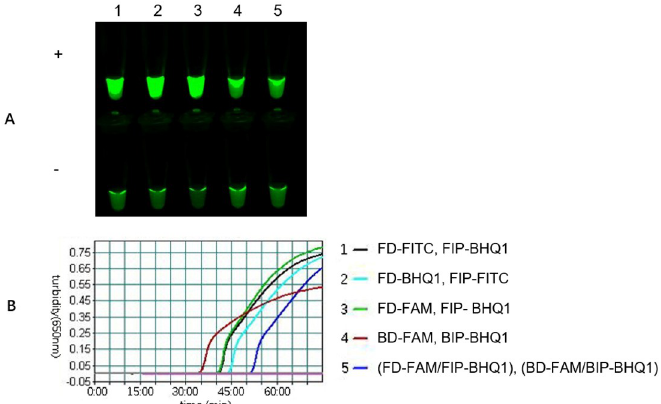
Fig 3. The effect of the labeling position of the fluorophore on the mLAMP reaction. The mLAMP products amplified by using FMDV-specific composite probes with fluorophores/quenchers labeling different positions were imaged using a 520 nm channel (A), and the turbidity curve was monitored by a real-time turbidimeter (B). 1: The FD-FITC/FIP-BHQ1 composite probe is composed of FD labeled with FITC at the 3’ end and FIP labeled with BHQ1 at the 5’ end, and the amplification product showed a robust fluorescence signal with a shorter initial reaction time. 2: For the FD-BHQ1/FIP-FITC composite probe with the quencher and fluorophore position reversed, the initial reaction time was slightly longer than that of composite probe 1. 3: The FD-FAM/FIP-BHQ1 composite probe had a similar fluorescence signal and initial reaction time as composite probe 1. 4: BD-FAM/BIP-BHQ1 composite probe labeled with fluorophore at the BIP terminus. 5: Both the FIP and BIP termini were labeled with fluorophores (FD-FAM/FIP-BHQ1, BD-FAM/BIP-BHQ1). Composite probes 4 and 5 inhibited mLAMP with a weak fluorescence signal compared to that of 1, 2 and